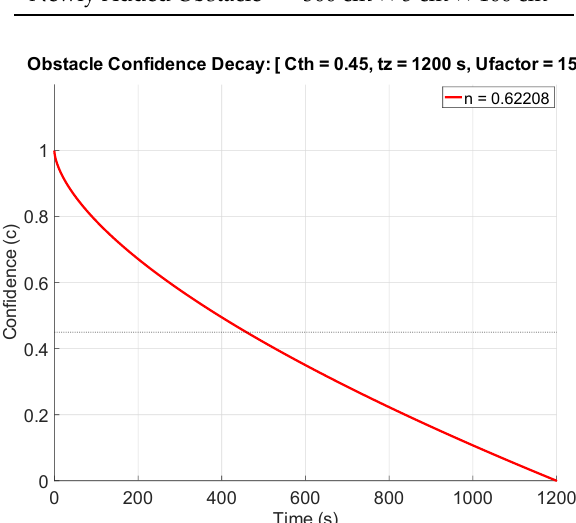
Figure 14. Confidence decay curve in the new experiment. C th = 0.45, t z = 1200 s, Ufactor =